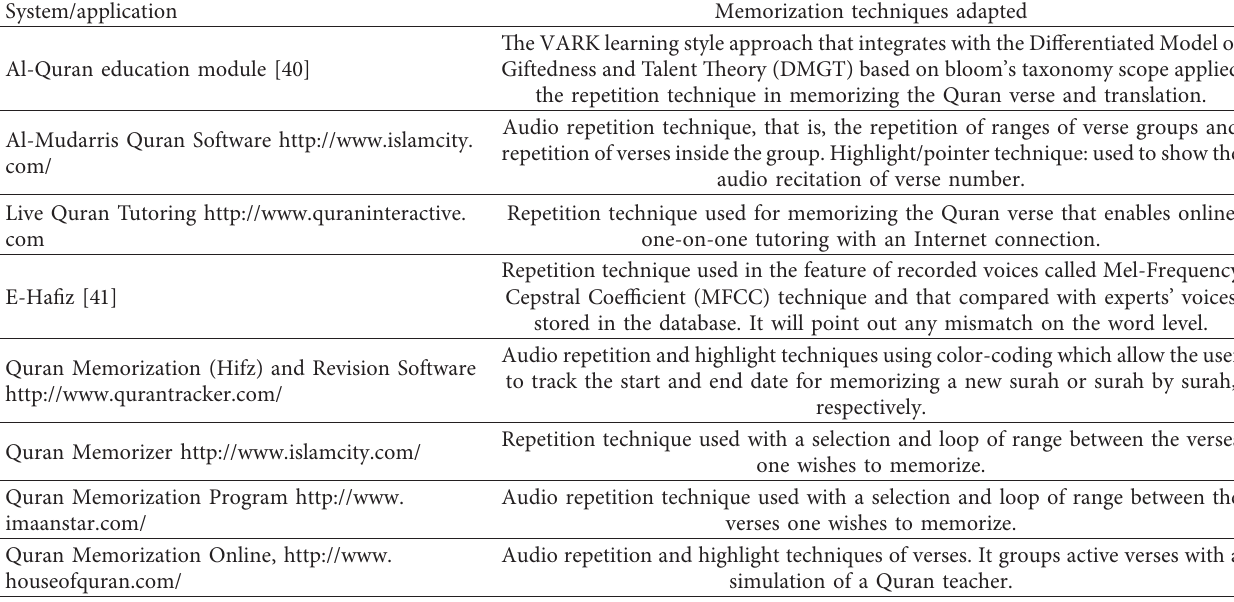
Table 2: Relevant system/application and memorization technique(s)